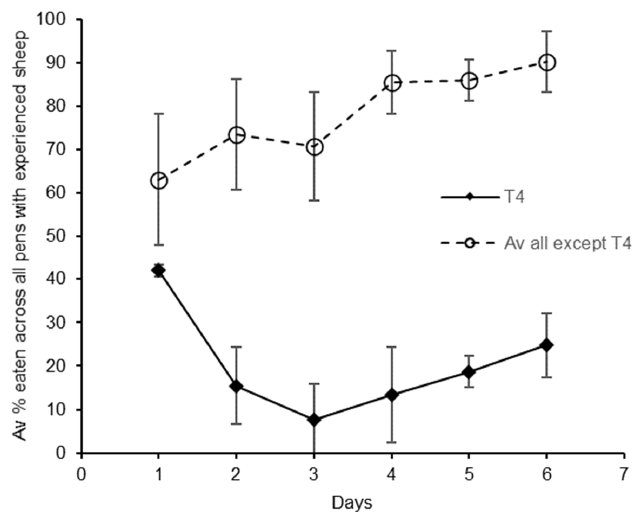
Figure 5. The combined average percentage eaten in the first hour of six tedera accessions (circles) offered in contrast with the average percentage eaten of tedera accession T4 (diamonds), by the experienced sheep over the six days of experiment 1. Note: Error bars are standard errors. Excluding accession T4, there was no significant accession by experience interaction and high correlation between experienced and naïve for the average percentage eaten af- ter one hour (r = 0.96). The VFI of the two groups of sheep are strongly associated. How- ever, there were significant differences between accessions ( p < 0.001) for the average per- centage eaten for both experienced and naïve sheep combined (Table 3). There was no correlation (r = 0.41) between sheep preference and the DM% (Fresh). Table 3. Overall preference ranking of all accessions in experiment 1 for the first hour of feeding over six days. Accessions that share no common letters are significantly different ( p < 0.05; LSD 11). Accession